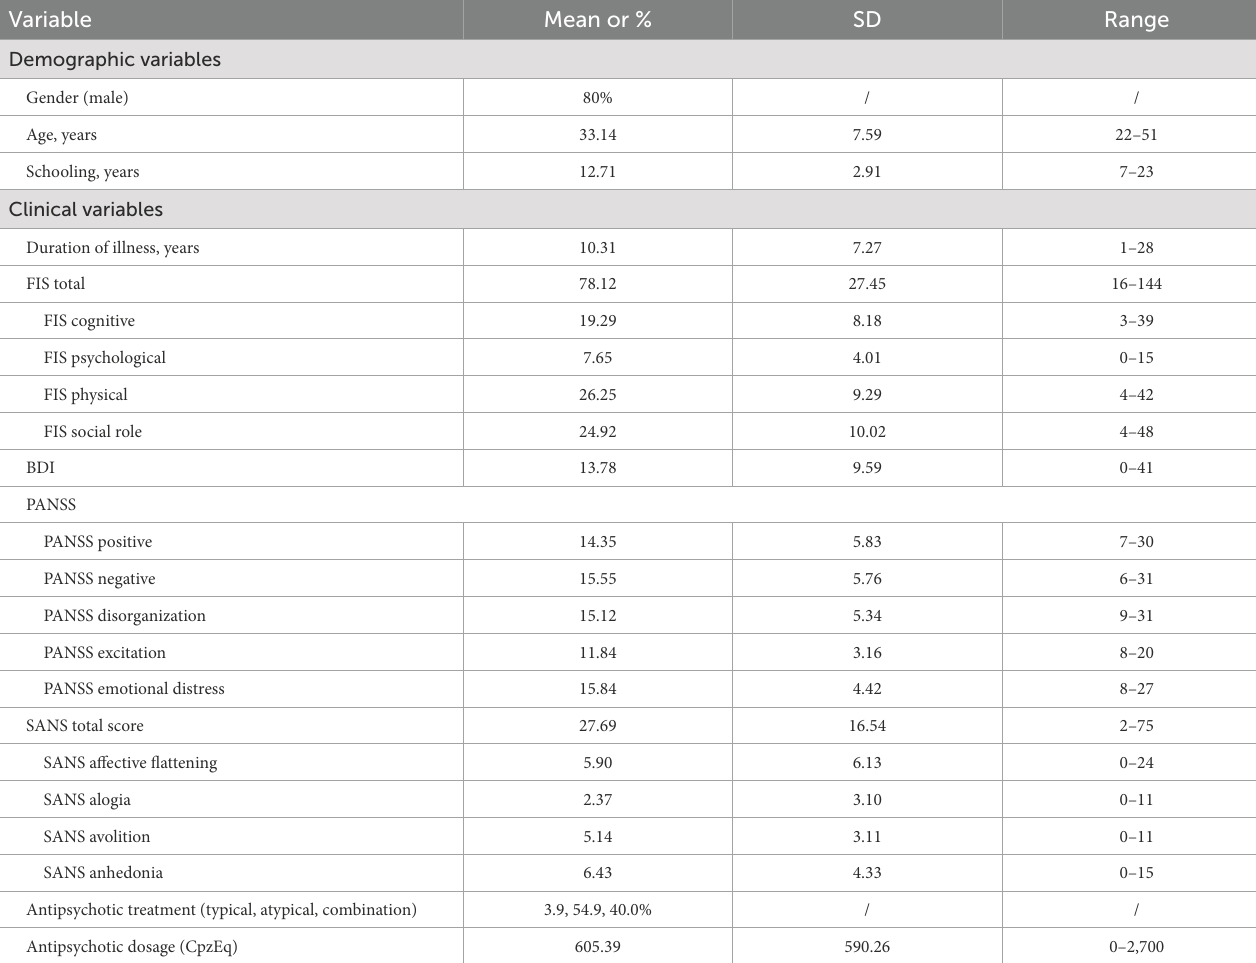
TABLE 1 Demographic and clinical variables for all participants; n = 51.